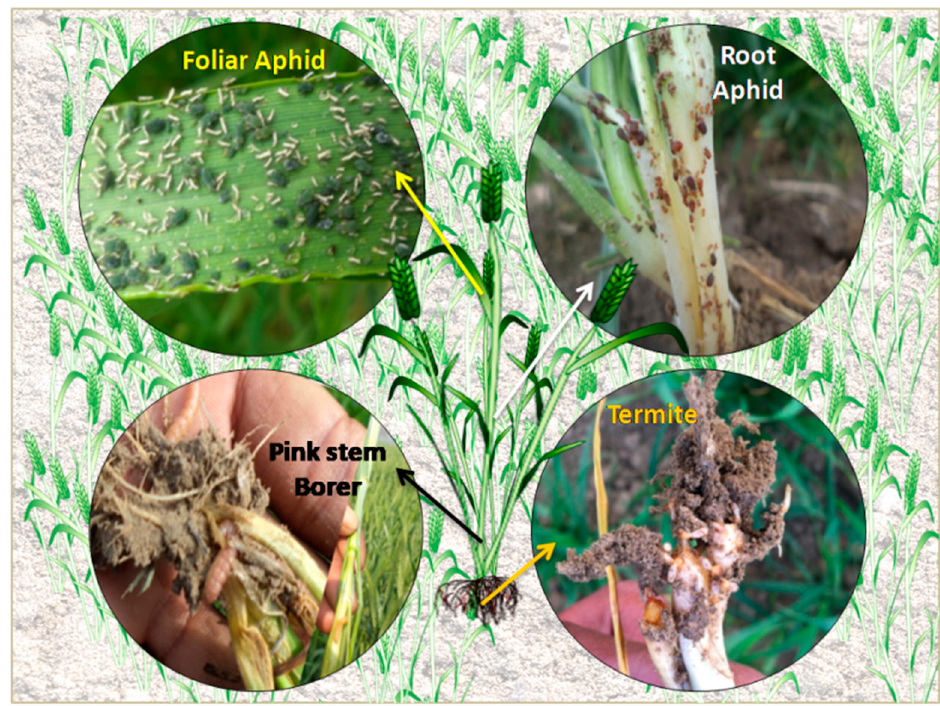
Figure 1. Major insect pests of wheat in the Indo-Gangetic Plain of India.